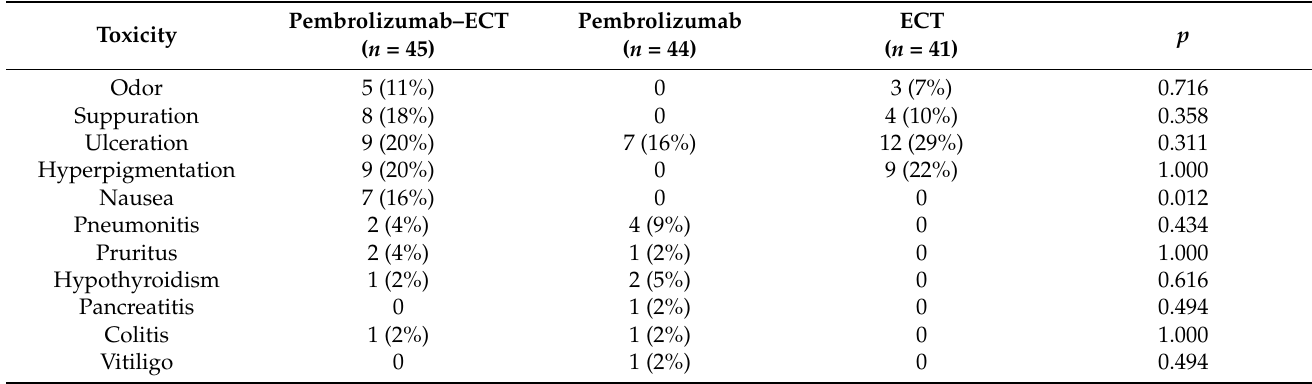
Table 2. Toxicity.